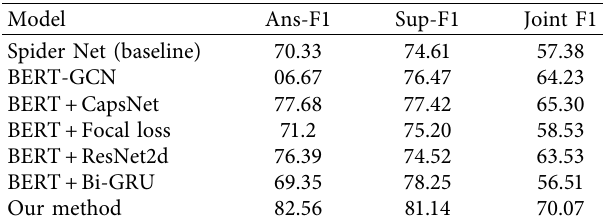
Table 7: Experimental results based on CJRC 2020 data set (bold is the optimal